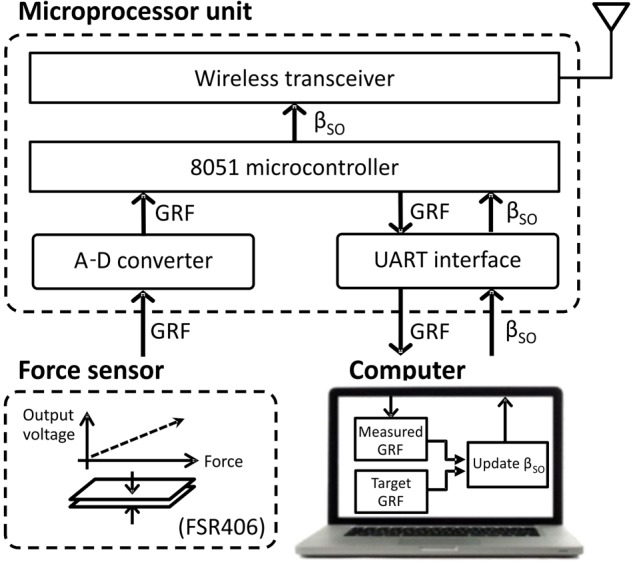
Block diagram of external devices (computer, ground force sensor, and microprocessor unit) that update the extension gain βSO, based on the ground reaction force (GRF) peak, and transmit it wirelessly to the prosthesis. See text for details.